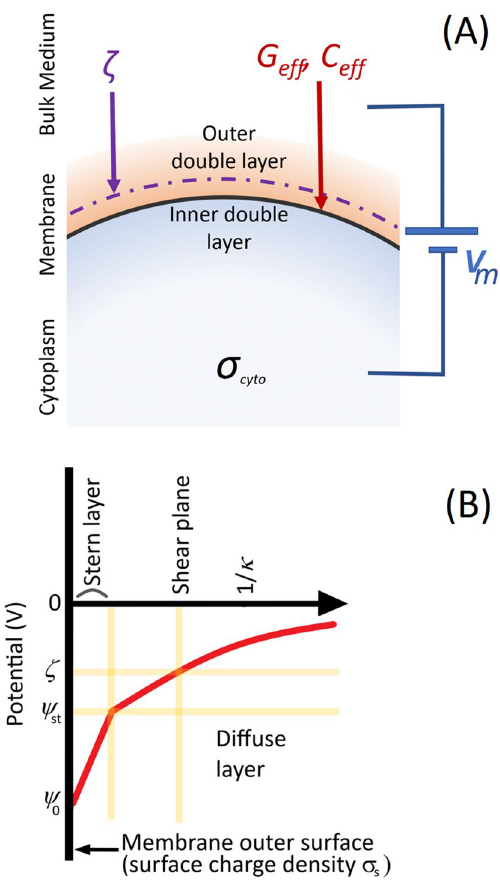
Figure 1. ( A ) A schematic of the cell, indicating the location of the electrical double layers, the shear plane (broken purple line) of ζ , the specific membrane conductance G eff and capacitance C eff , cytoplasm conductivity σ cyto and membrane potential V m . ( B ) The variation in potential from the cell surface, showing the location of the Stern layer and the shear plane at which ζ is